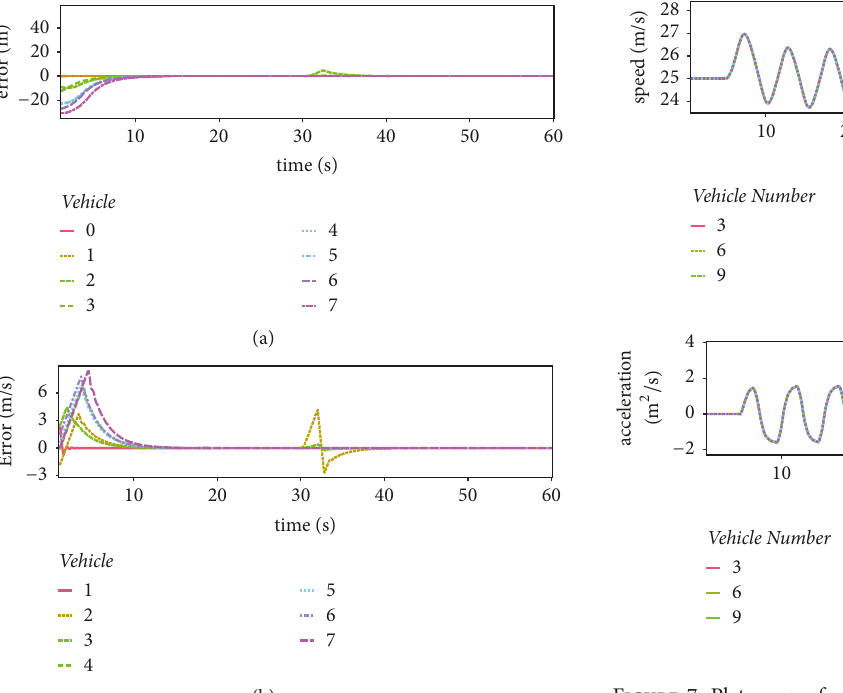
Figure 7: Platoon performance in the presence of the sinusoidal disturbance scenario under different platoon lengths: (a) speed; (b)